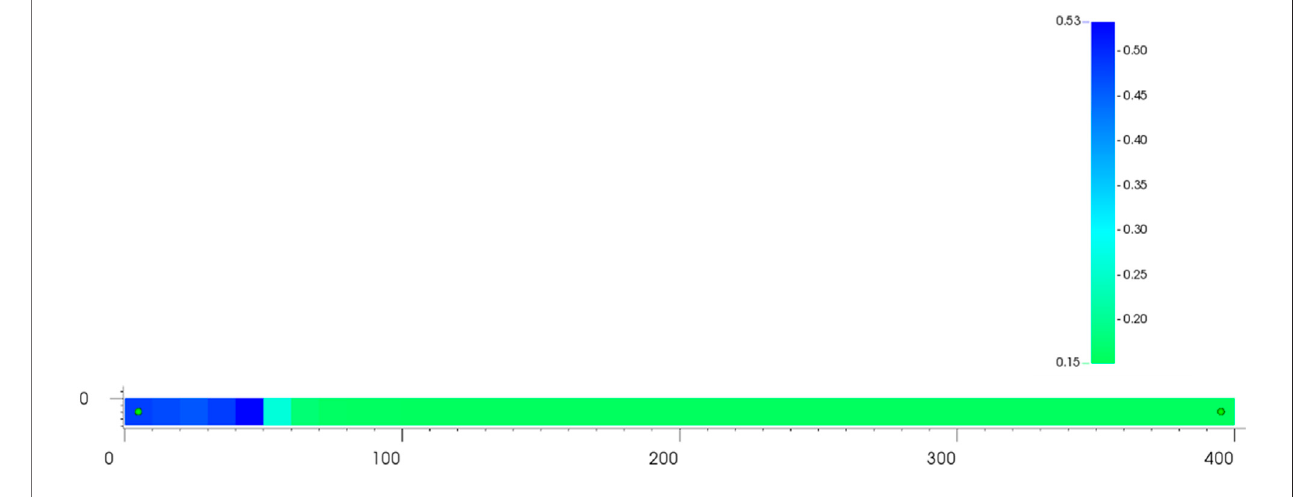
FIGURE 2 | Liquid water saturation.